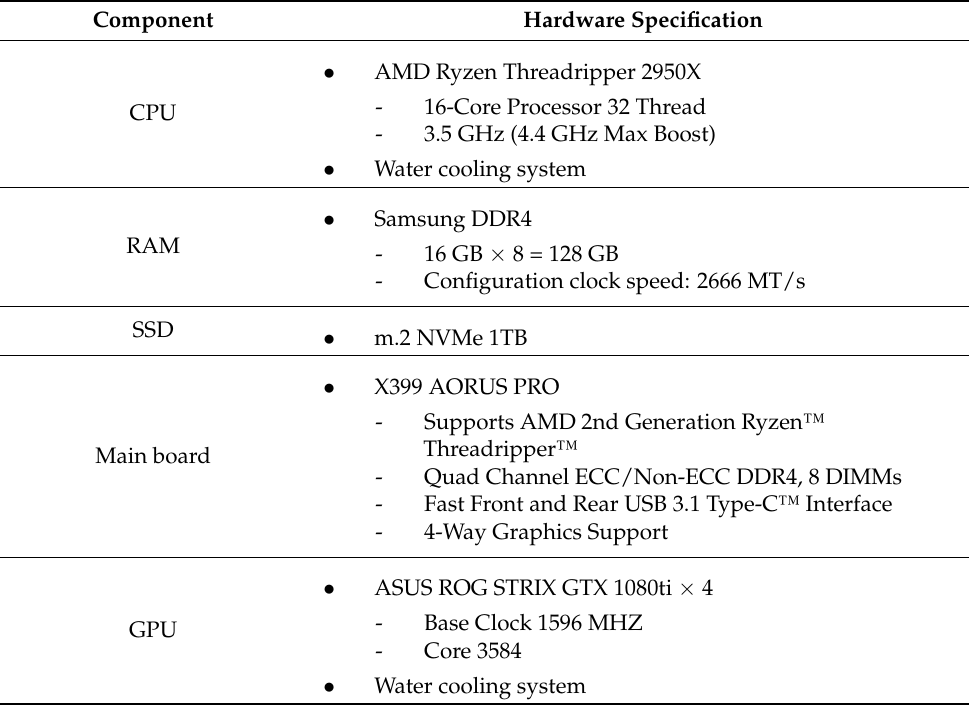
Table 2. The component hardware specification of the GPU workstation device (Figure 1c).